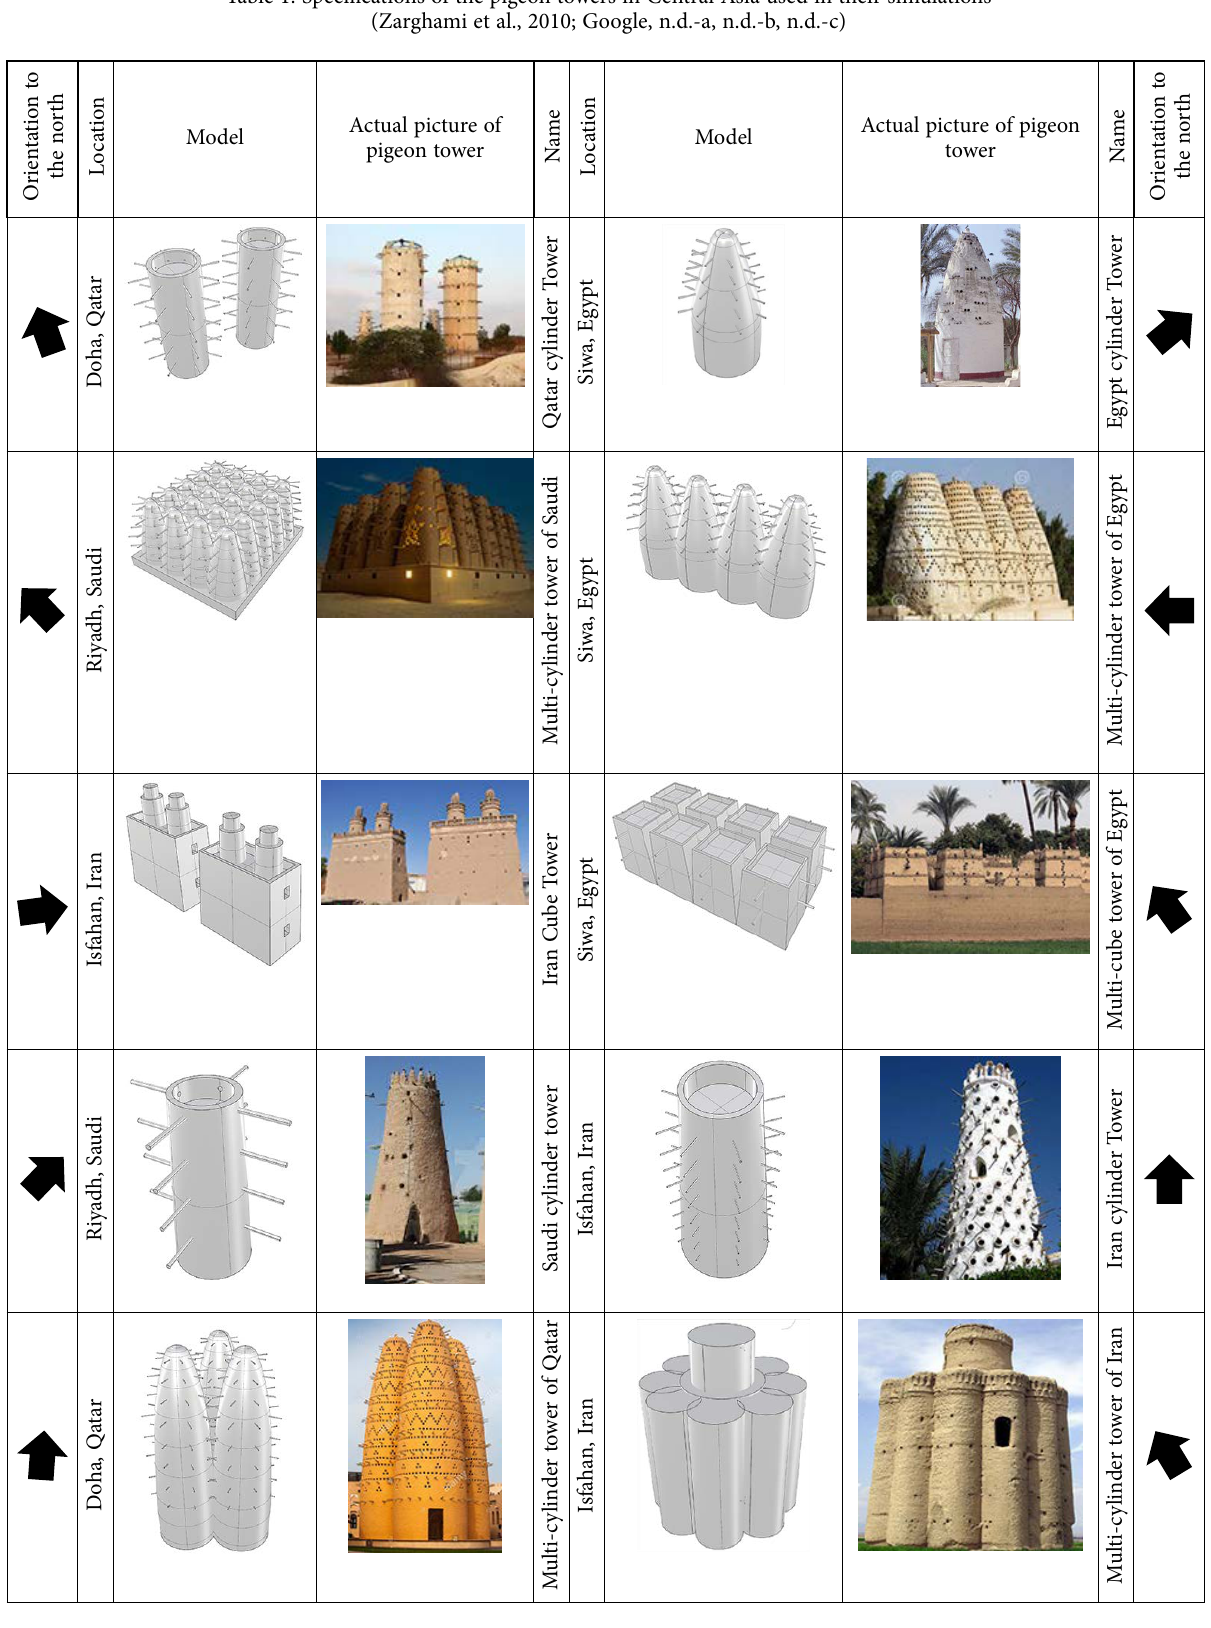
Table 1. Specifications of the pigeon towers in Central Asia used in their simulations (Zarghami et al., 2010; Google, n.d.-a, n.d.-b, n.d.-c)